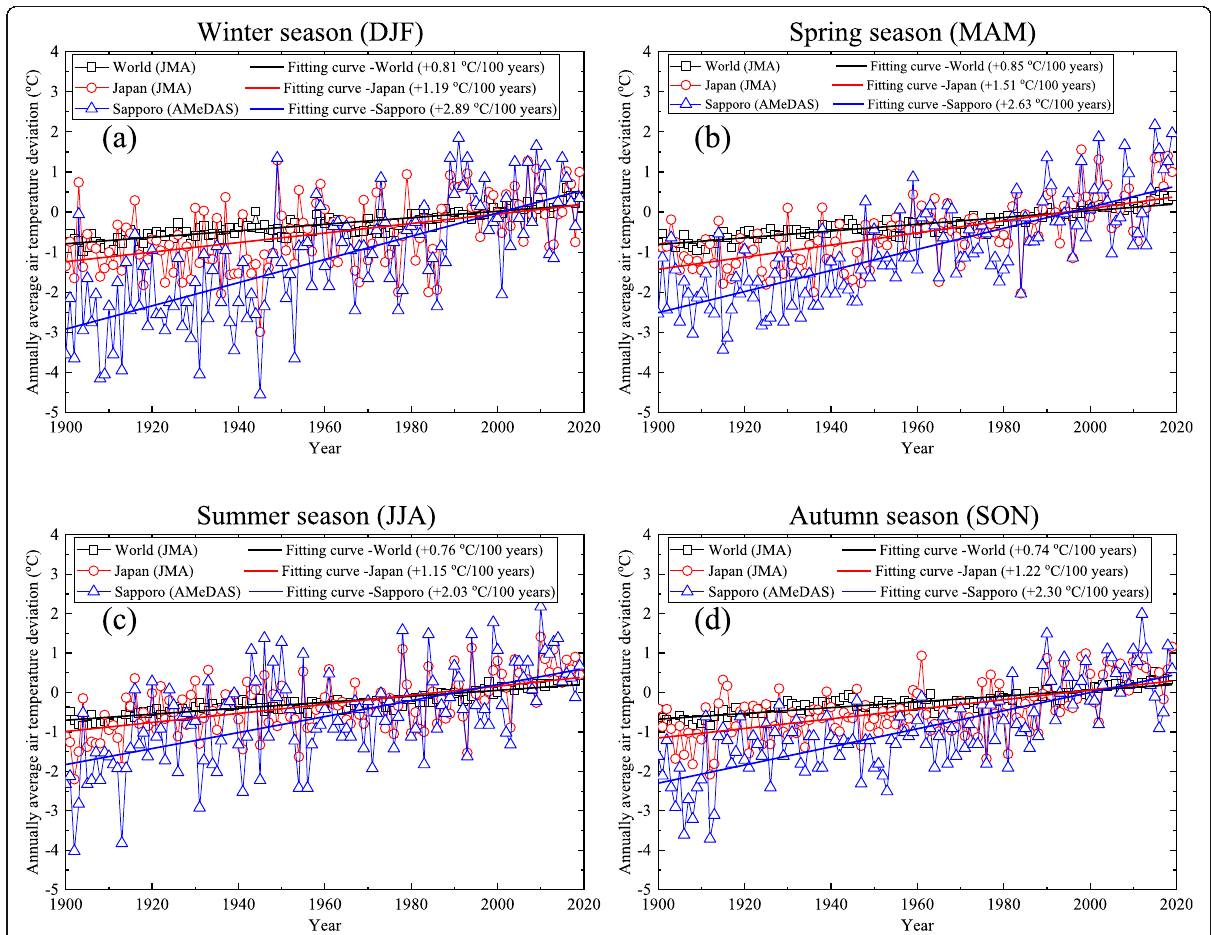
Fig. 3 Temperature of the world, Japan, and Sapporo change in different seasons, ( a ) DJF; ( b ) MAM; ( c ) JJA, and ( d )